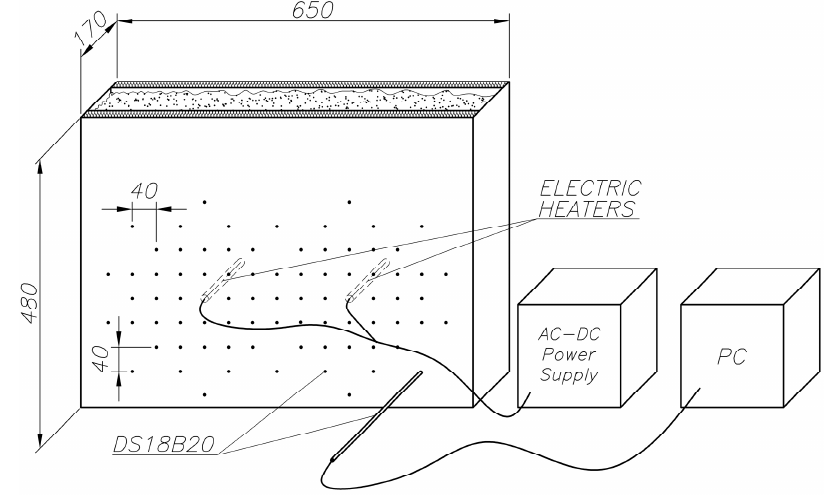
Figure 10. Experiment system with location of temperature sensors.